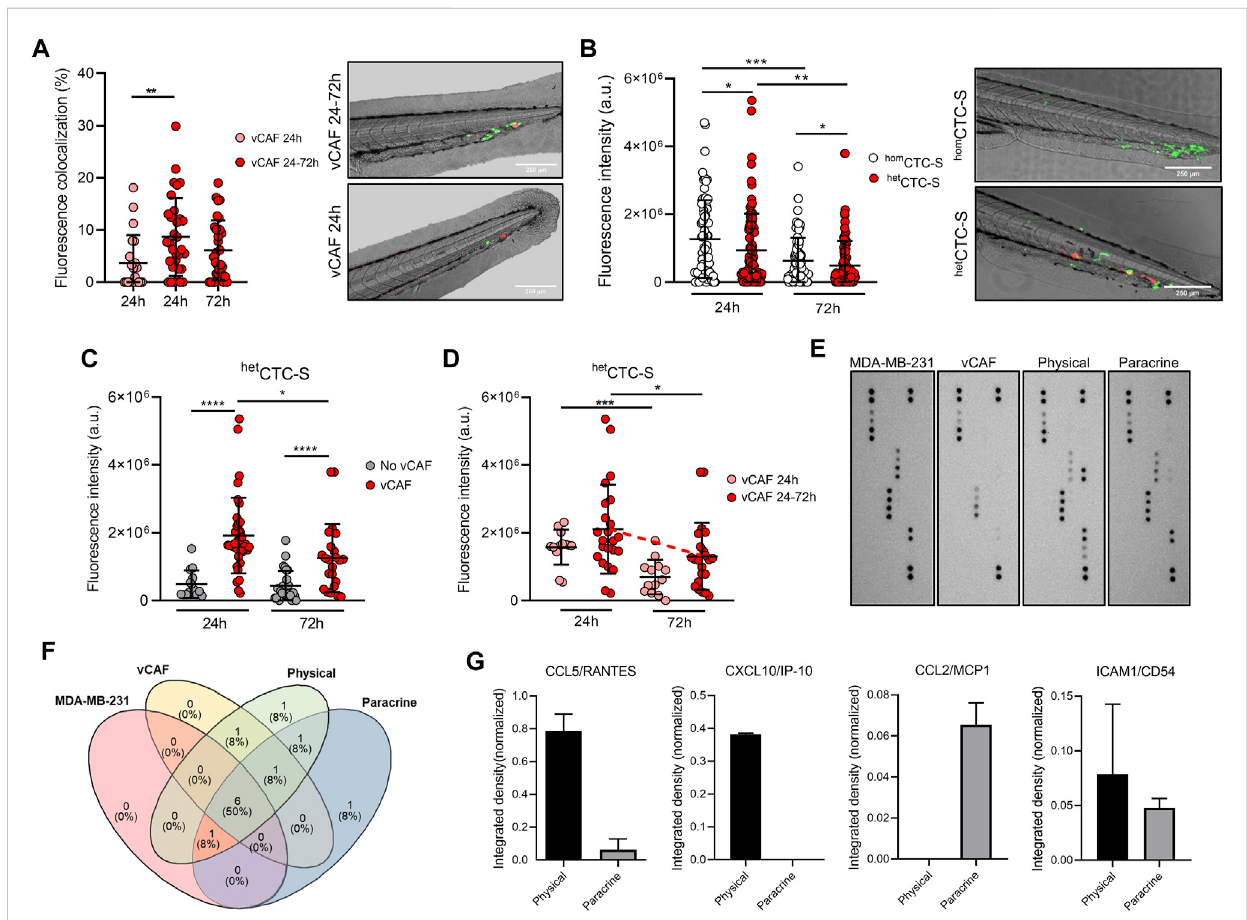
FIGURE 5 Analysis of colocalization of CTCs and CAFs in the zebra fi sh embryo and cytokine pro fi le. (A) Dot plot showing the percentage of fl uorescence overlap between the signal emitted by the disseminated MDA-MB-231 and vCAF cells, and representative images of the tails (scale bar 250 µm); (B) Dot plot of the fl uorescence intensity in the tail of fi sh xenografted with MDA-MB-231 hom CTC-S and vCAF het CTC-S, and representative images of the tails (scale bar 250 µm). Each dot represents an individual fi sh; (C) Dot plots of the fl uorescence intensity of MDA-MB-231 disseminated in the fi sh tails xenografted with MDA-MB-231 hom CTC-S and vCAF het CTC-S according to the presence or absence of vCAF; (D) Dot plots of the fl uorescence intensity ofMDA-MB-231 het disseminatedCTC-Sinthe fi shtailsaccordingtothesurvivalofvCAF; (E) Imagesofthemembranesofanantibodyarrayevaluatingthe production of cytokines and chemokines in the culture medium of monocultures and co-cultures of MDA-MB-231 and vCAF cells under physical and paracrine interaction. (F) Venn diagram showing the cytokine/chemokine overlap among culturing conditions; (G) Level of cytokines/chemokines exclusively detected under physical and paracrine conditions. * p < 0.05, ** p < 0.01, *** p <